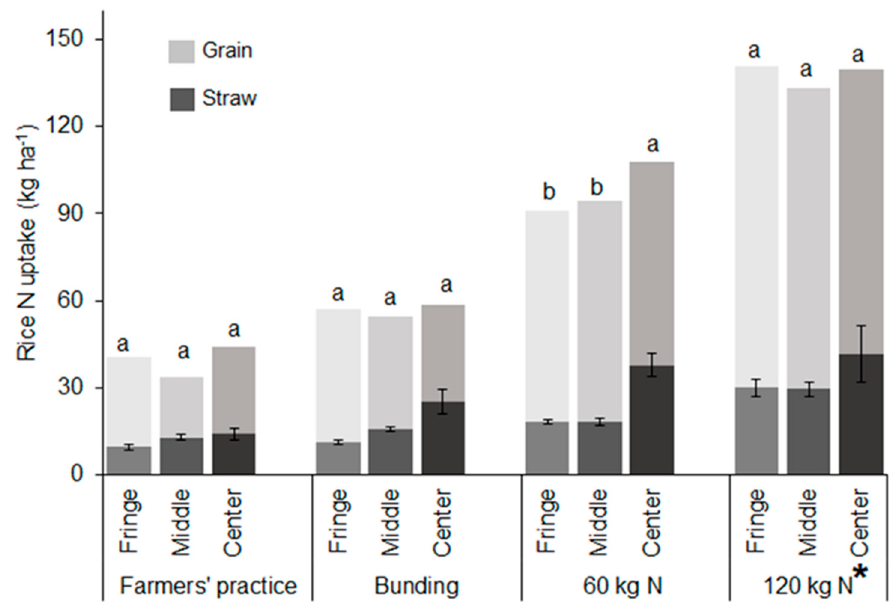
Figure 5. Nitrogen uptake by rice grain and straw across years (2015–2017) as affected by management practices. Different letters indicate significant differences by Tukey test at p ≤ 0.05 between positions. * “Attainable yield” treatments comprised of supplementary application of P and K .